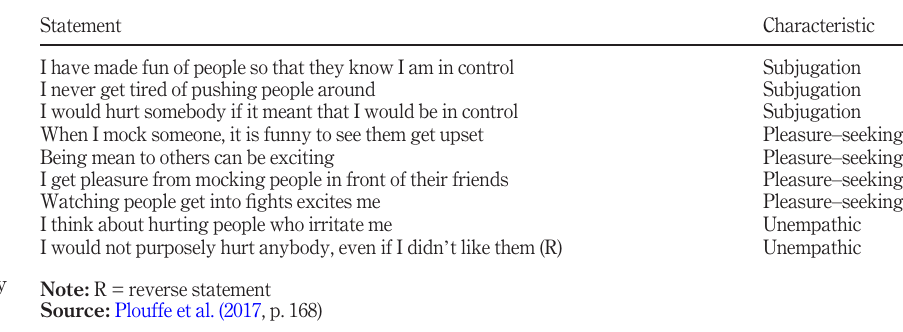
Table II. Assessment of sadistic